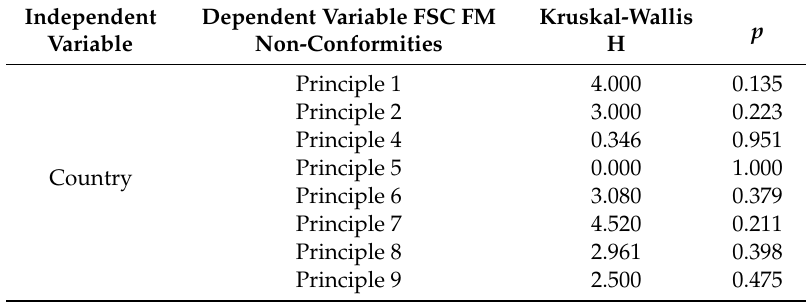
Table A1. Statistical results of Kruskal-Wallis test.